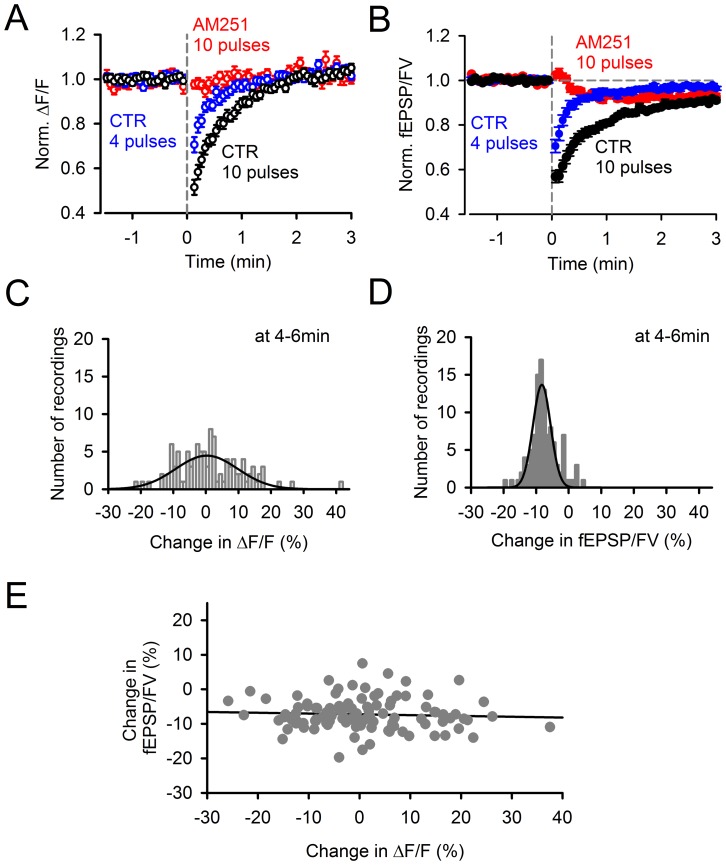
The persistent PTD is not associated with detectable changes in presynaptic calcium signaling.
A, Effect of a 200 Hz burst on the PF action potential-evoked residual presynaptic calcium transients. Presynaptic calcium transients evoked by double pulse stimulation were recorded as the normalized change in fluorescence (ΔF/F) of GCaMP2 expressed in the axons of granule cells. ΔF/F was reduced during the minute following induction by a train of 10 (n = 34; black) or 4 (n = 35; blue) pulses at 200 Hz. However, no reduction of ΔF/F was observed in 2 µM AM251 (n = 13; red). B, Normalized fEPSP/FV for the same data, on the same expanded time scale for comparison with (A). C, Distribution histogram of the change in ΔF/F 4–6 min after a 10-pulse burst at 200 Hz (n = 107; pooled control and conditions in which neither the persistent PTD nor synaptic transmission were affected). This distribution exhibits a high variability partly due to the low signal-to-noise of the ΔF/F recordings. Gaussian fit peaks at +0.3%. D, Distribution histogram of the change in fEPSP/FV 4–6 min following induction (i.e., the opposite of persistent PTD amplitude) for the same recordings. Gaussian fit peaks at −8.3%. E, Data shown in (D) plotted against data shown in (C). The persistent PTD amplitude does not correlate with ΔF/F (p = 0.6; Spearman Rank correlation).